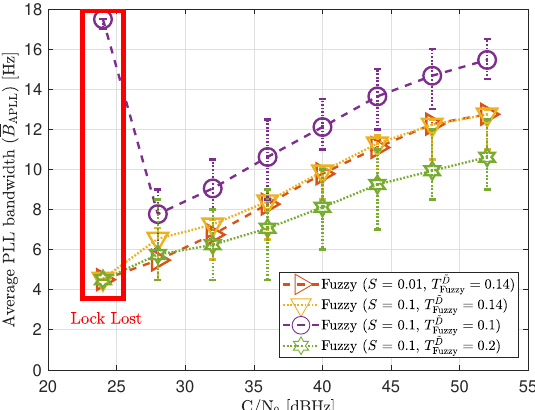
Figure 22. Average FL PLL loop bandwidth of SV G4 tracking in static scenario.